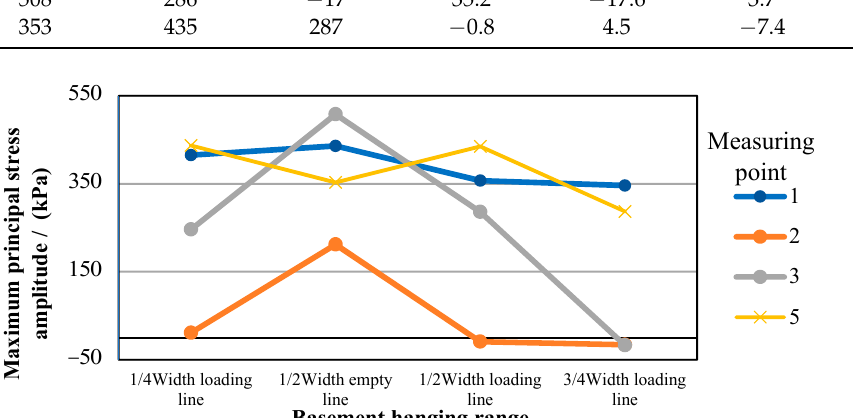
Figure 16. Maximum principal stress increment amplitude diagram of measuring points 1, 2, 3, and 5 under different basement hanging ranges.